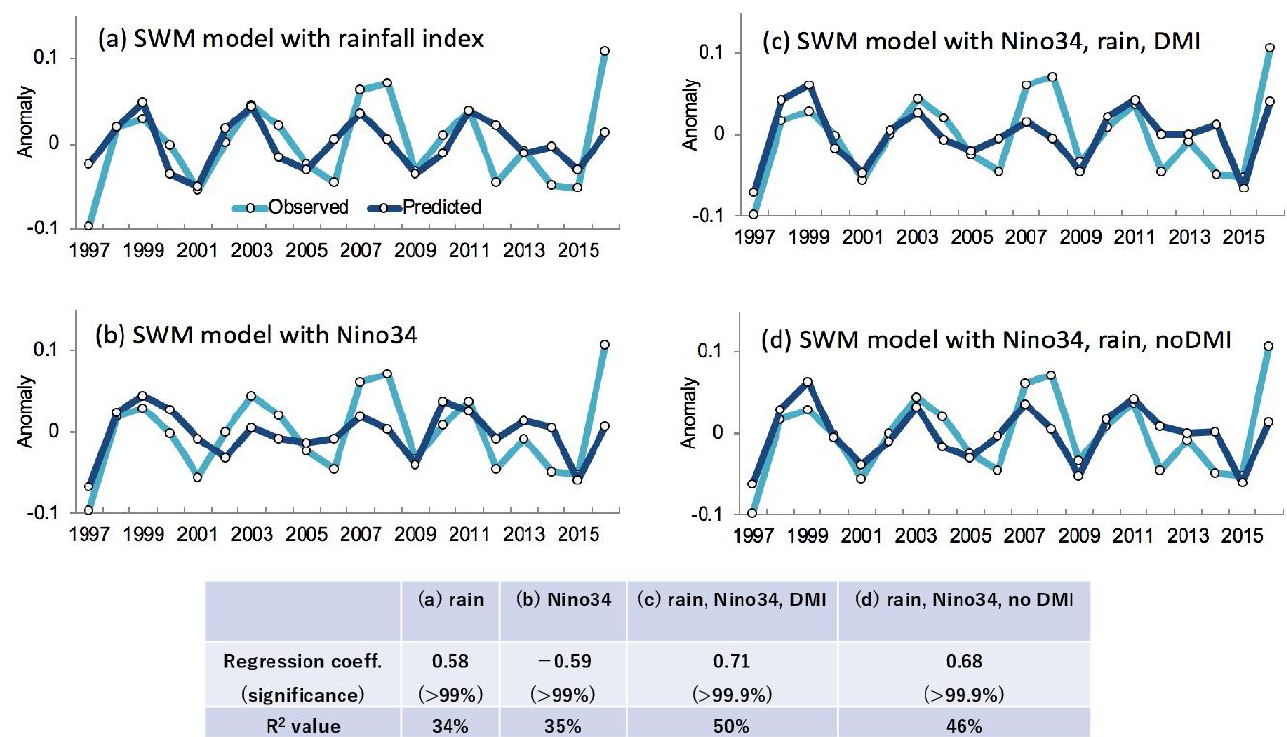
Figure 4. Regression model to predict SWM over the north BoB. Time series of fall SWM anomaly over the north BoB (20–23° N, 85–95° E) over 1997–2016: observed (blue curves) and predicted (purple curves) using a regression model based on ( a ) August–Sepetember (AS) rainfall anomaly over north India (20–30° N, 75–90° E), ( b ) June–September (JJAS) Nino 3.4 anomaly, ( c ) AS rainfall, JJAS Nino 3.4 anomalies, and JJAS Dipole Mode Index (DMI), and ( d ) AS rainfall, JJAS Nino-3.4, no DMI anomalies.